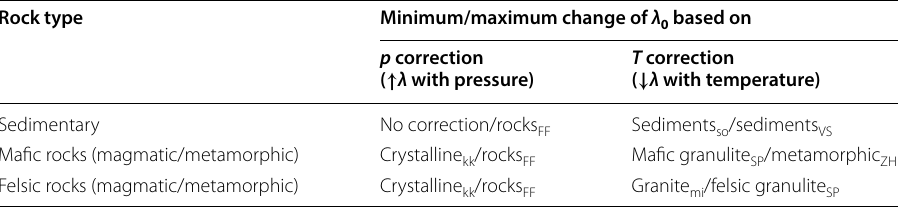
For abbreviations see Fig.